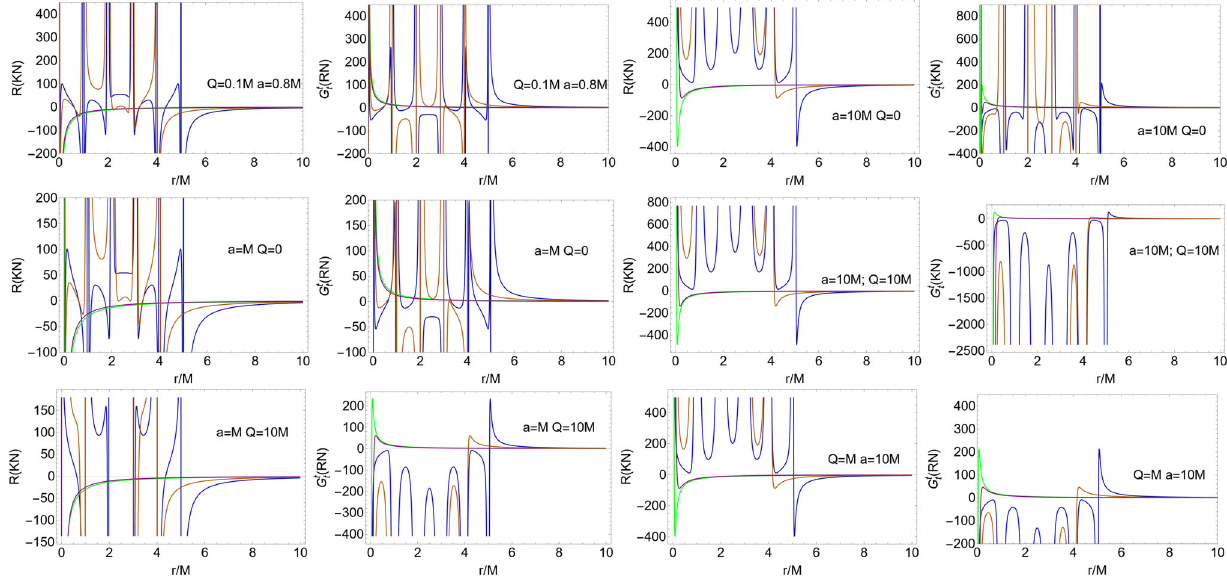
Fig. 22 Deformation of the Kerr–Newman reference metric and Kerr reference metric ( Q = 0 ) in Boyer–Lindquist coordinates (metric signature ( − , + , + , + ) ) on the equatorial plane ( θ = π/ 2). Ricci curvature scalar R and Einstein tensor component G t